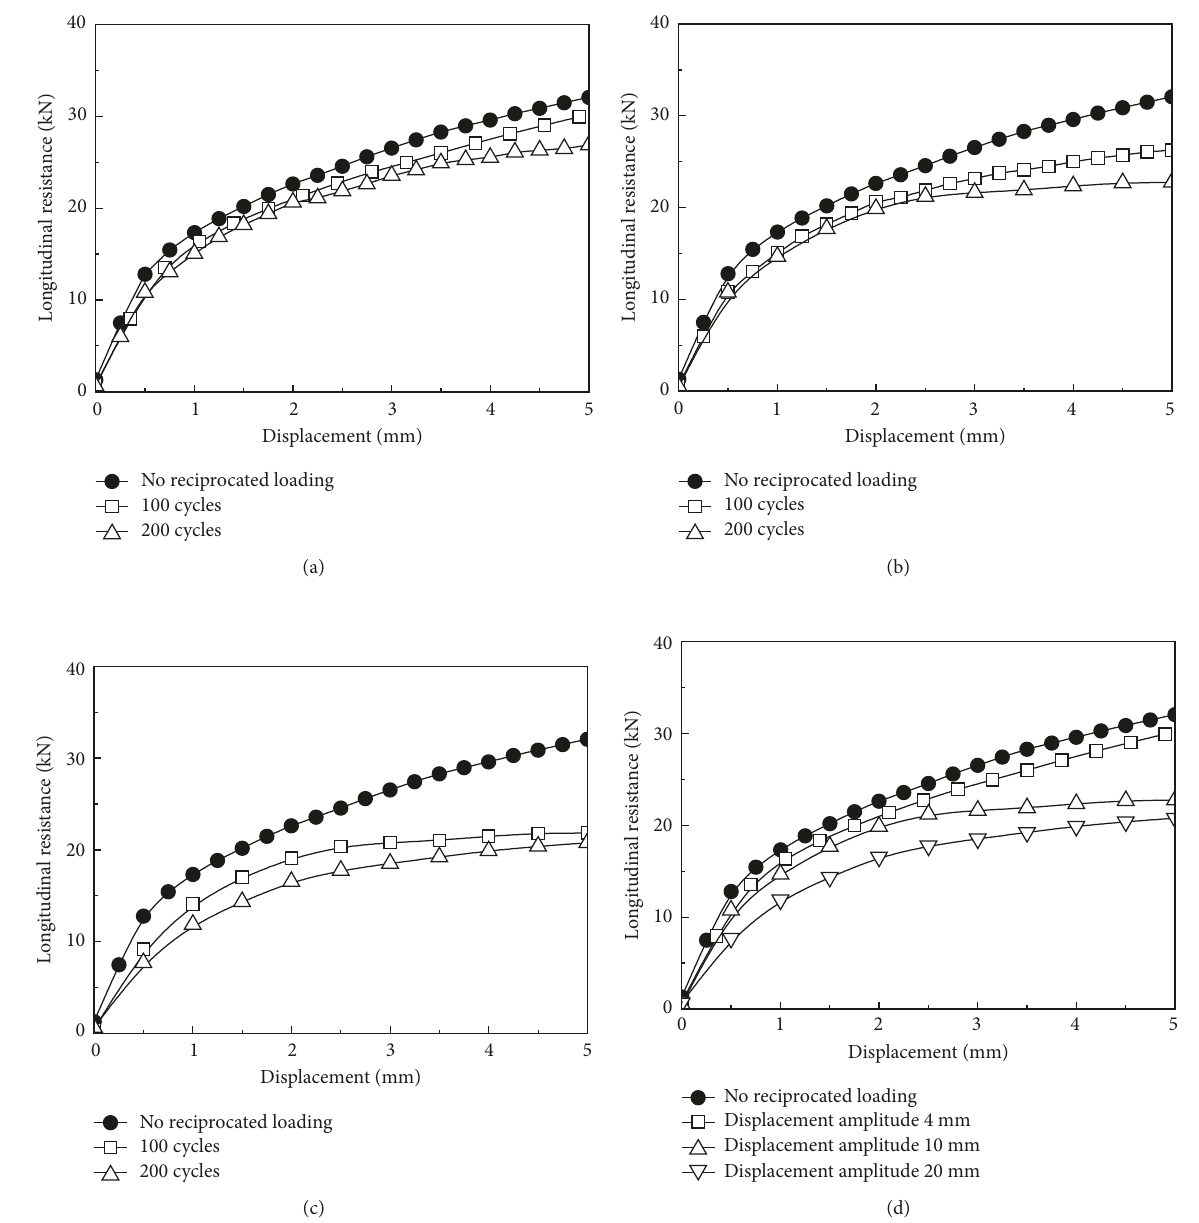
Figure 7: Ballast longitudinal resistance displacement curves: (a) displacement amplitude 4mm, (b) displacement amplitude 10mm, (c) displacement amplitude 20mm, and (d) relationship between ballast resistance and